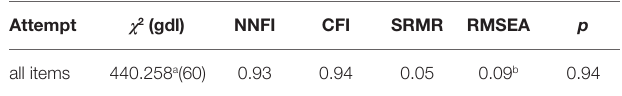
TABLE 5 | Fit indices – “work purpose.”